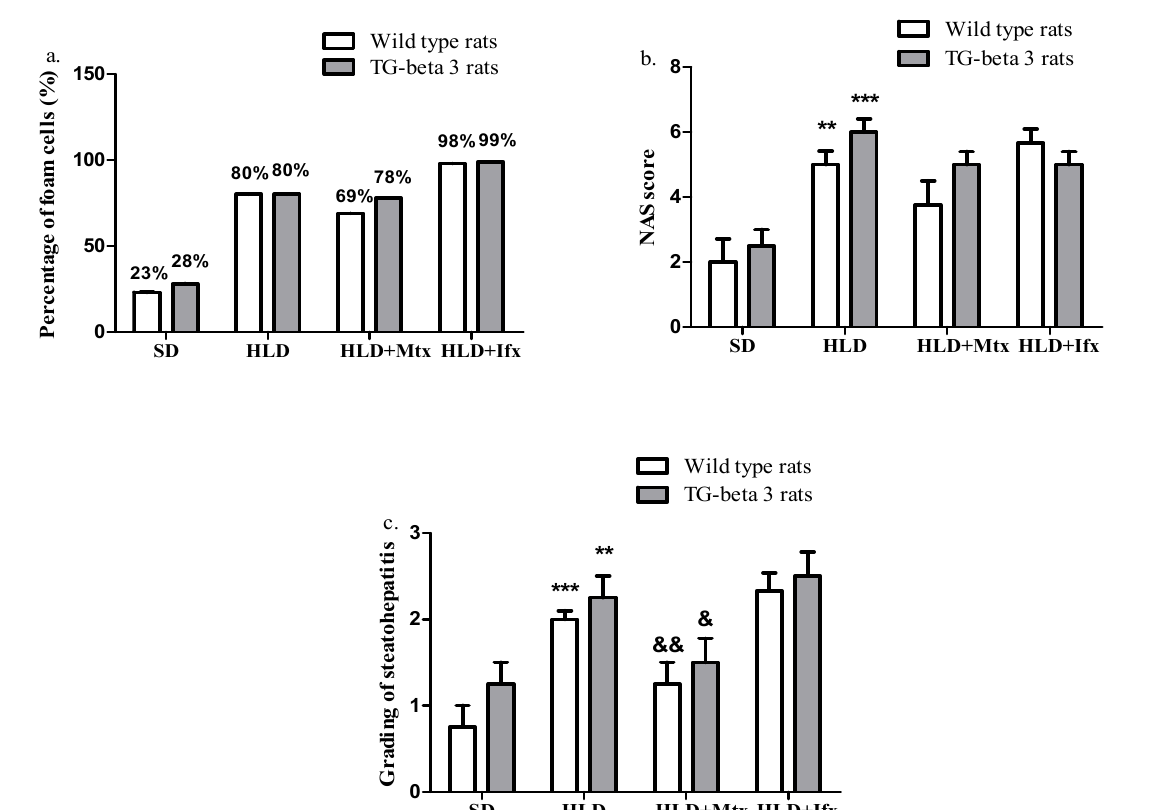
Figure 7. Histopathological analysis of liver. ( a ) Percentage of foam cells in the liver, ( b ) non-alcoholic fatty liver disease activity score (NAS), ( c ) grading of steatohepatitis. 1—mild, 2—moderate, 3—severe. SD—standard diet; HLD—high lipid diet; Mtx-methotrexate; Ifx-infliximab; HLD + Mtx—high lipid diet associated with methotrexate; HLD + Ifx—high lipid diet associated with infliximab. ** p < 0.01; *** p < 0.001 HLD versus SD group; & p < 0.05; && p < 0.01 HLD + Mtx versus SD group.